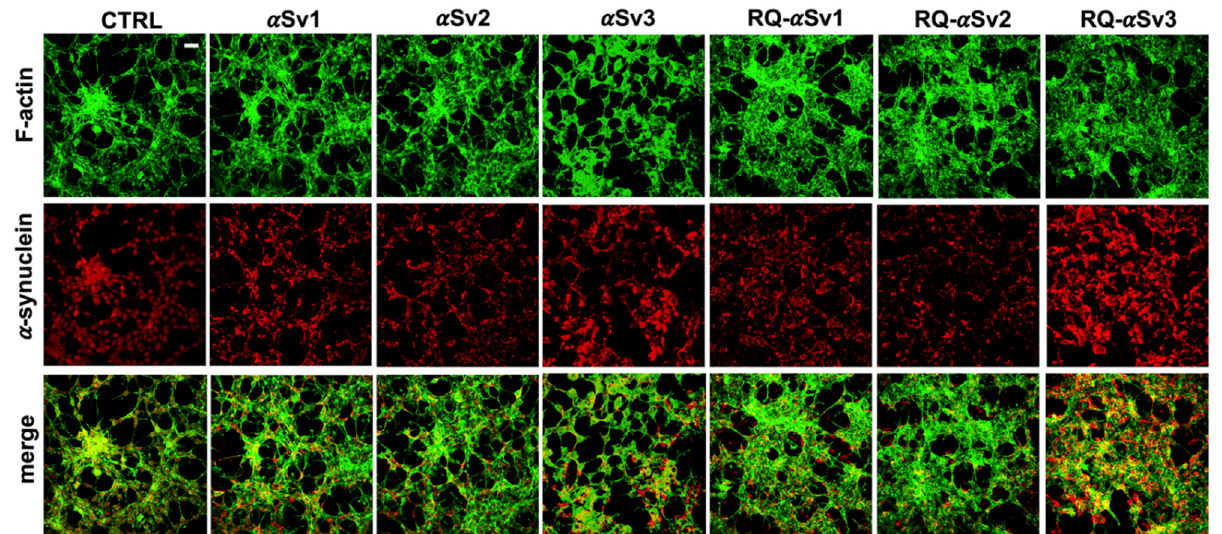
Figure 7 . Intracellular α Syn aggregates in SH-SY5Y cells stimulated with α Sv1, α Sv2, α Sv3 and their α Syn_RT-QuIC reaction products (RQ- α Sv1, RQ- α Sv2, and RQ- α Sv3). SH-SY5Y cells, stimulated with α Sv1, α Sv2, α Sv3, RQ- α Sv1, RQ- α Sv2, RQ- α Sv3 (2.5 µM for 24 h) and control (CTRL), were stained for α Syn (red) to visualize the cellular aggregates. With respect to CTRL, all stimulated SH-SY5Y cells showed clusters of α Syn aggregates that were more abundant in those challenged with both α Sv3 and RQ- α Sv3. Cells were counterstained with Alexa-Fluor 488-Phalloidin (green) to highlight the thin neurite-like cytoplasmic structures (cell-to-cell contacts) denoted by F-actin filaments. The cytoskeleton of the cells was preserved, regardless of the presence of α Syn aggregates. Scale bar = 25µm.